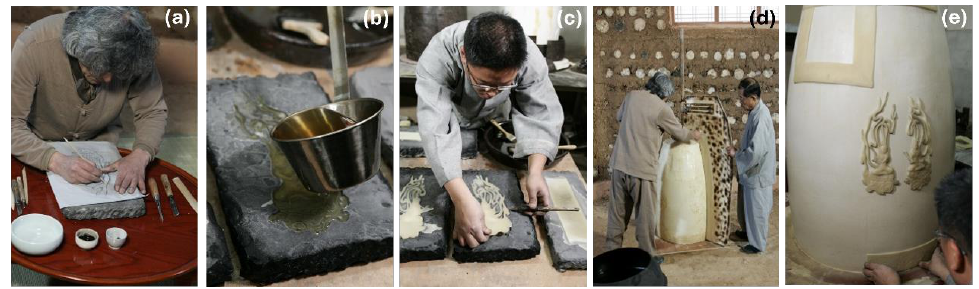
Figure 9. The fabrication process of a beeswax form [110,116]. ( a ) Pattern engraving, ( b ) beeswax pouring, ( c ) beeswax patterning, ( d ) plane beeswax form, and ( e ) beeswax bell form.